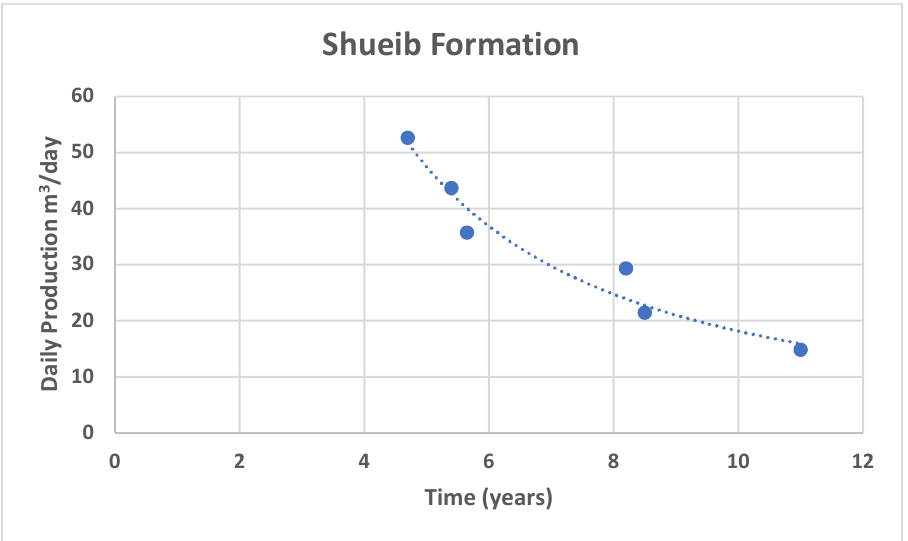
Figure 19. Water breakthrough daily production for the Shueib formation.